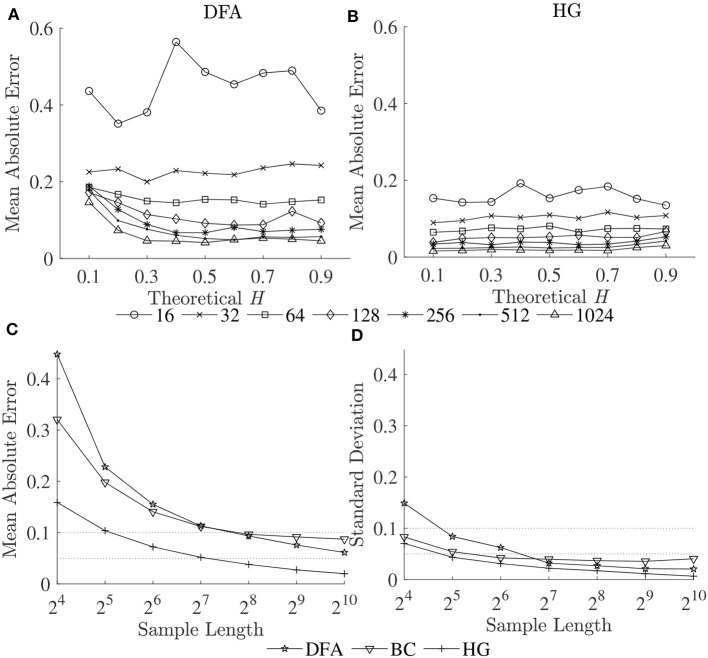
Mean absolute errors of estimated Ĥ vs. theoretical H for (A) DFA and (B) HG; and (C) mean absolute errors and (D) standard deviations of estimated Ĥ over a possible range (0.1–0.9) vs. sample length (16–1,024 data points).